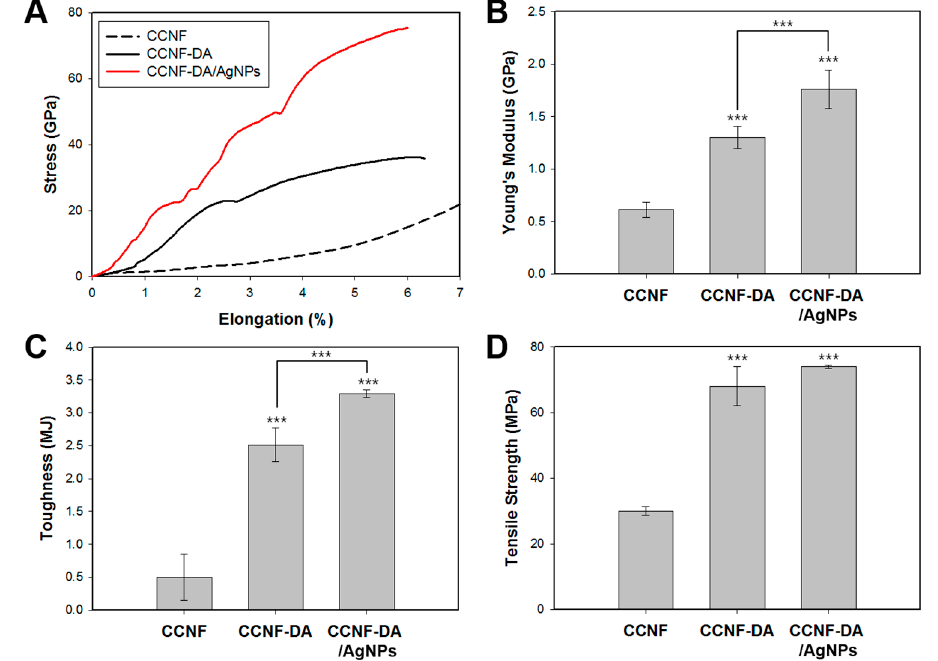
Figure 4. ( A ) Stress-strain curve; ( B ) tensile strength; ( C ) toughness; and ( D ) Young’s modulus of CCNF, CCNF-DA, and CCNF-DA/AgNPs films. The data of quadruplicate samples represent